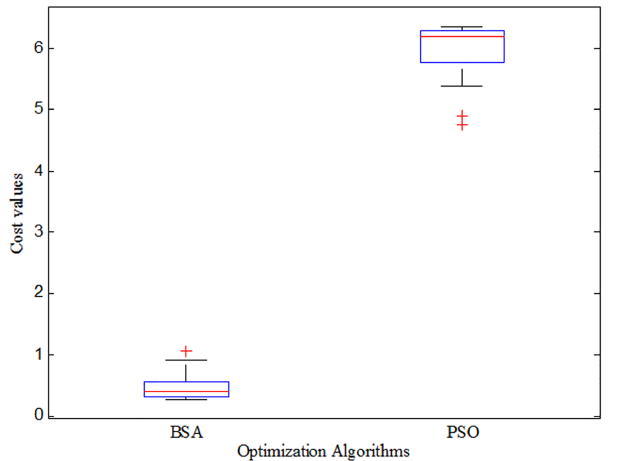
Fig 7. Statistical box and whisker plots of each algorithm obtained from 15 individual simulation in linear model of multimachine power system.